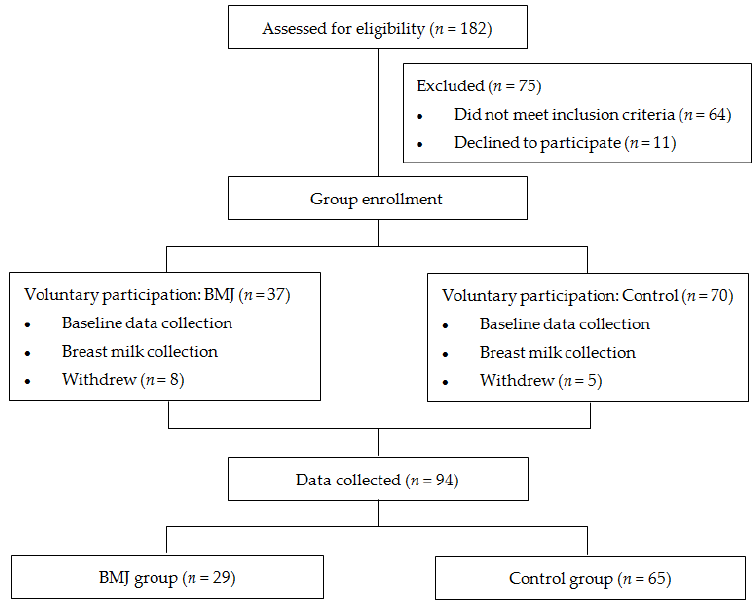
Figure 1. Flowchart. Figure 1.